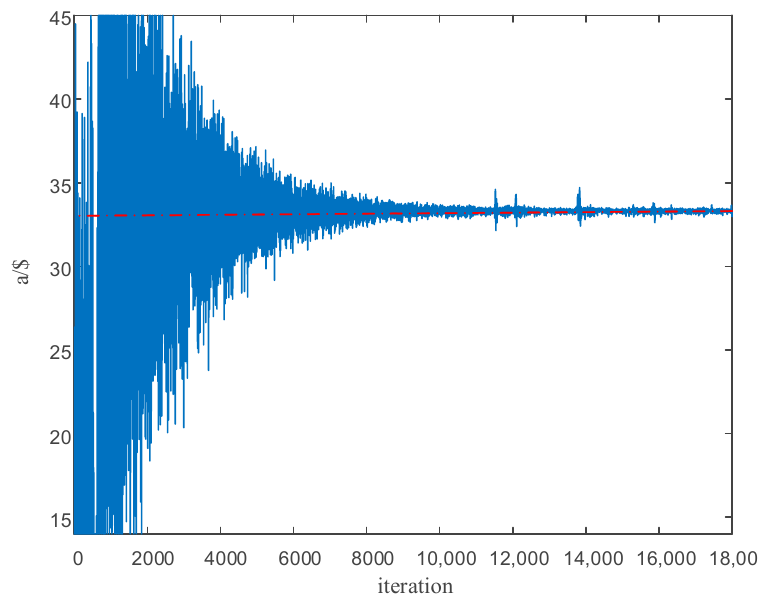
Figure 6. The iterative curve of action.